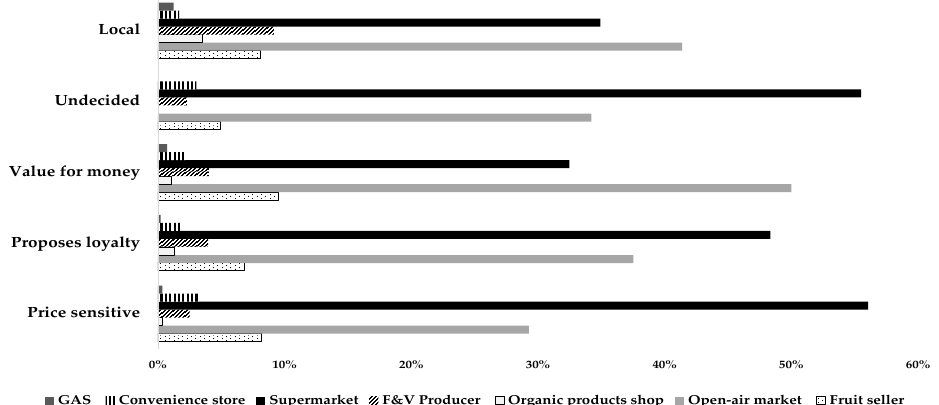
Figure 6. The points of purchase of fruit and vegetables chosen by consumers belonging to the five selected clusters.